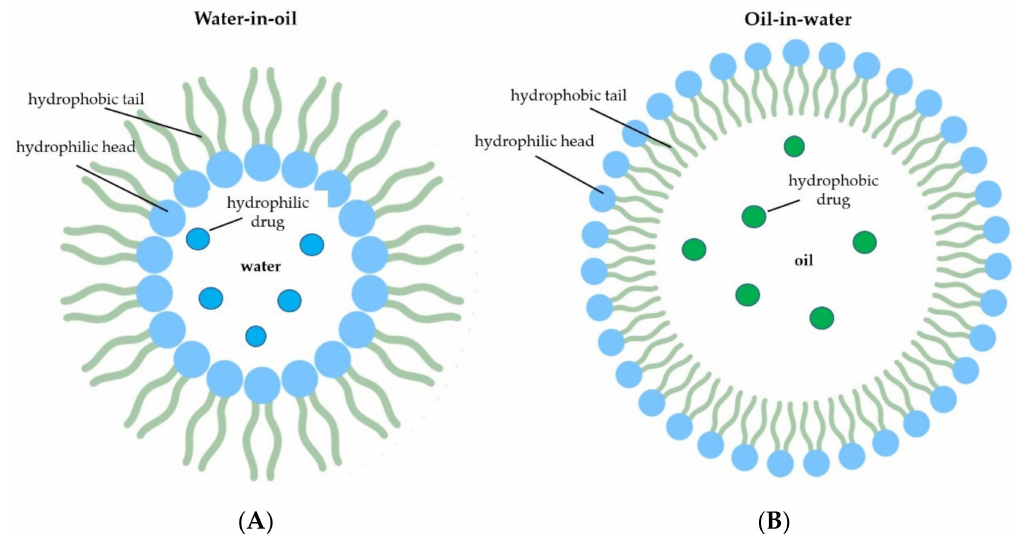
Figure 3. Schematic representation of nanoemulsions. Water-in-oil, where water and a hydrophilic compound are dispersed in an oily medium ( A ) and oil-in-water, in which the oil and the hydrophobic compound is dispersed in an aqueous phase ( B